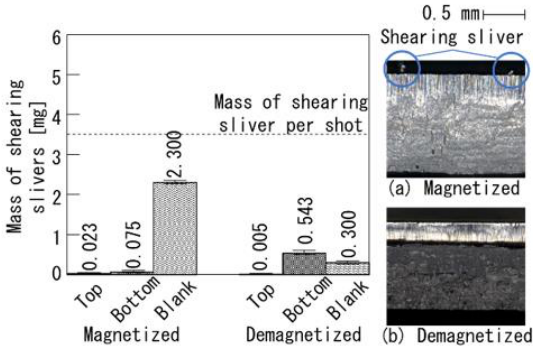
Figure 14. Sheared surface and scattering mass of shearing slivers of sheared 1180 MPa steel sheet: (a) magnetized sheet and (b) demagnetized sheet.